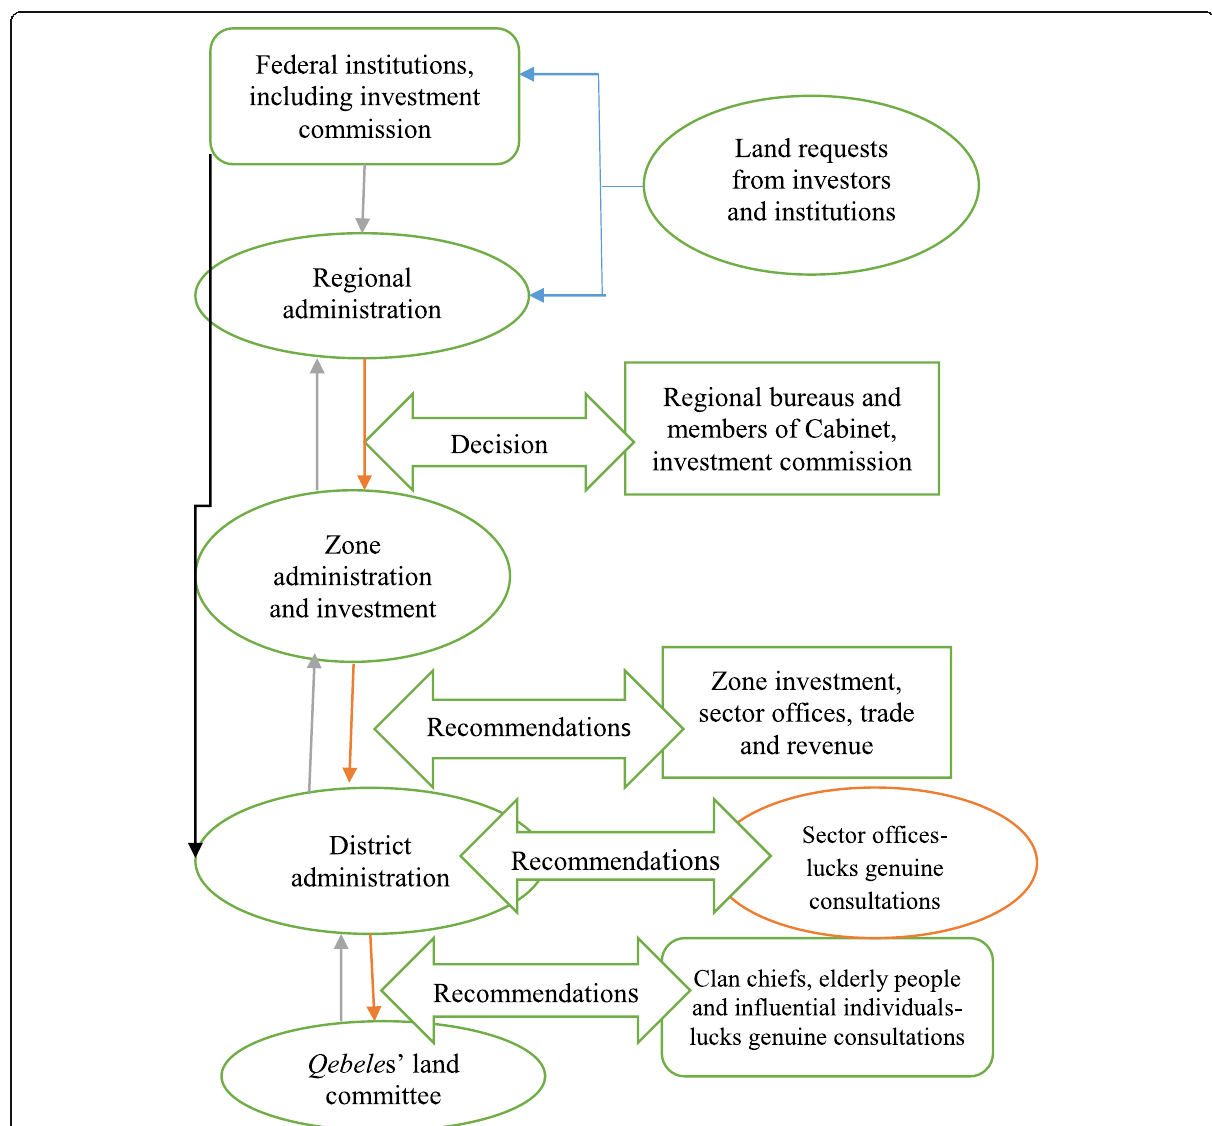
Fig. 3 Local land governance-investment decision process in the SNNPR, organized top-down (based on key informant interviews at district, zone, and region levels). (It was also mentioned by key informants at the Woreda (district), zone, and region that mostly decisions are made at the federal and regional levels without sufficient public consultations. If the consultation occurs, it is usually